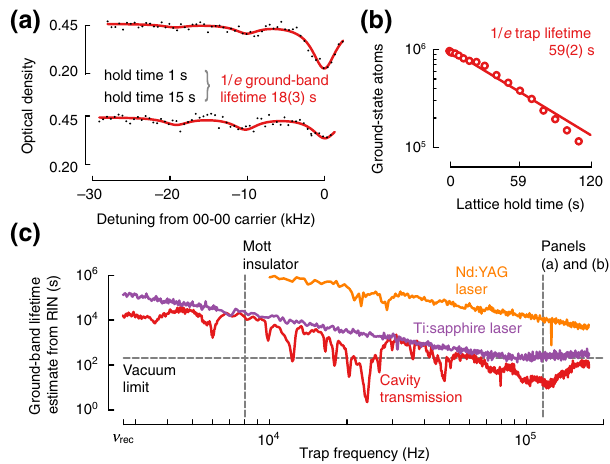
FIG. 6. The lifetime in the cavity lattices. (a) Resolved car- rier spectra in the cavity lattices at a trap depth (frequency) of 457 E rec (116 kHz). The spectrum on the top (bottom) is taken after holding atoms for 1 s (15 s) in the lattices. We extract a 1 / e lattice-ground-band lifetime of 18 ( 3 ) s. (b) The number of g atoms as a function of the lattice hold time. We extract an overall 1 / e trap lifetime of 59(2) s. (c) The estimated ground- band lifetime of different laser sources as a function of the lattice depth. Here, we consider three different sources: a Ti:sapphire laser (purple), which is the input light to the cavity; a Ti:sapphire laser transmitted through cavity 2 (red); and a high intensity- stable Nd:YAG laser (orange). Our lifetime measurement at a trap depth (frequency) of 457 E rec (116 kHz) shown in (a) and the relative-intensity-noise (RIN) measurements of a Ti:sapphire laser transmitted through cavity 2 at this trap frequency provide a reference value. The estimation is performed by rescaling the RIN of these laser sources with respect to this reference